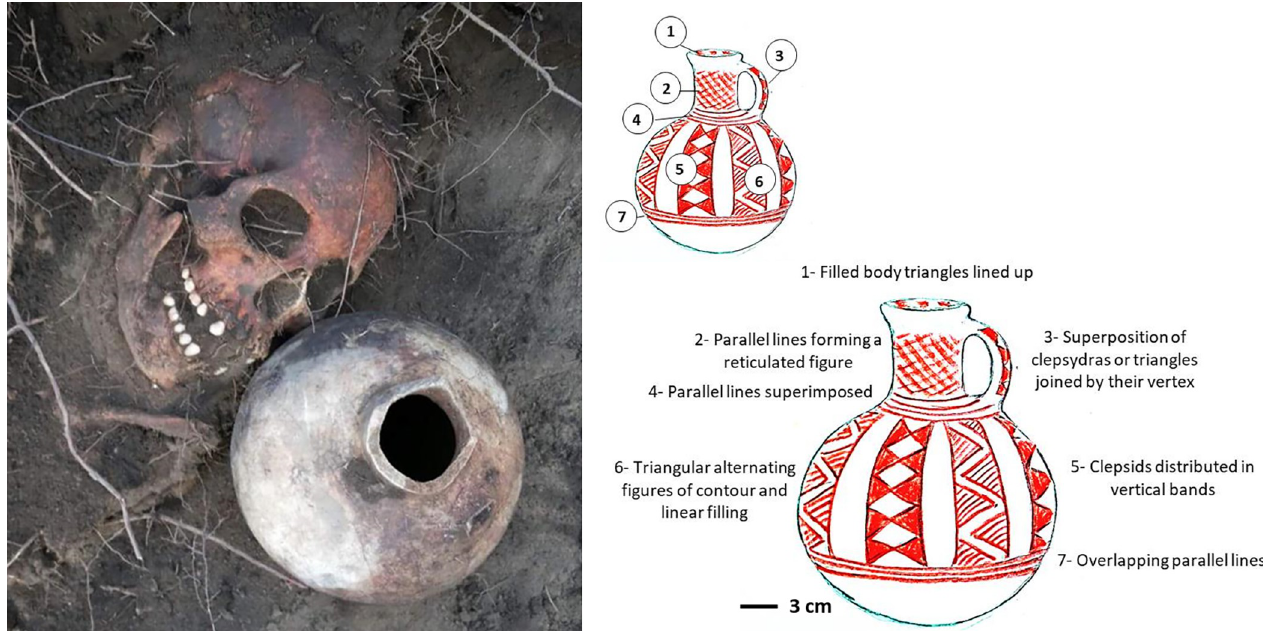
Fig 5. El Vergel pot from Burial N˚